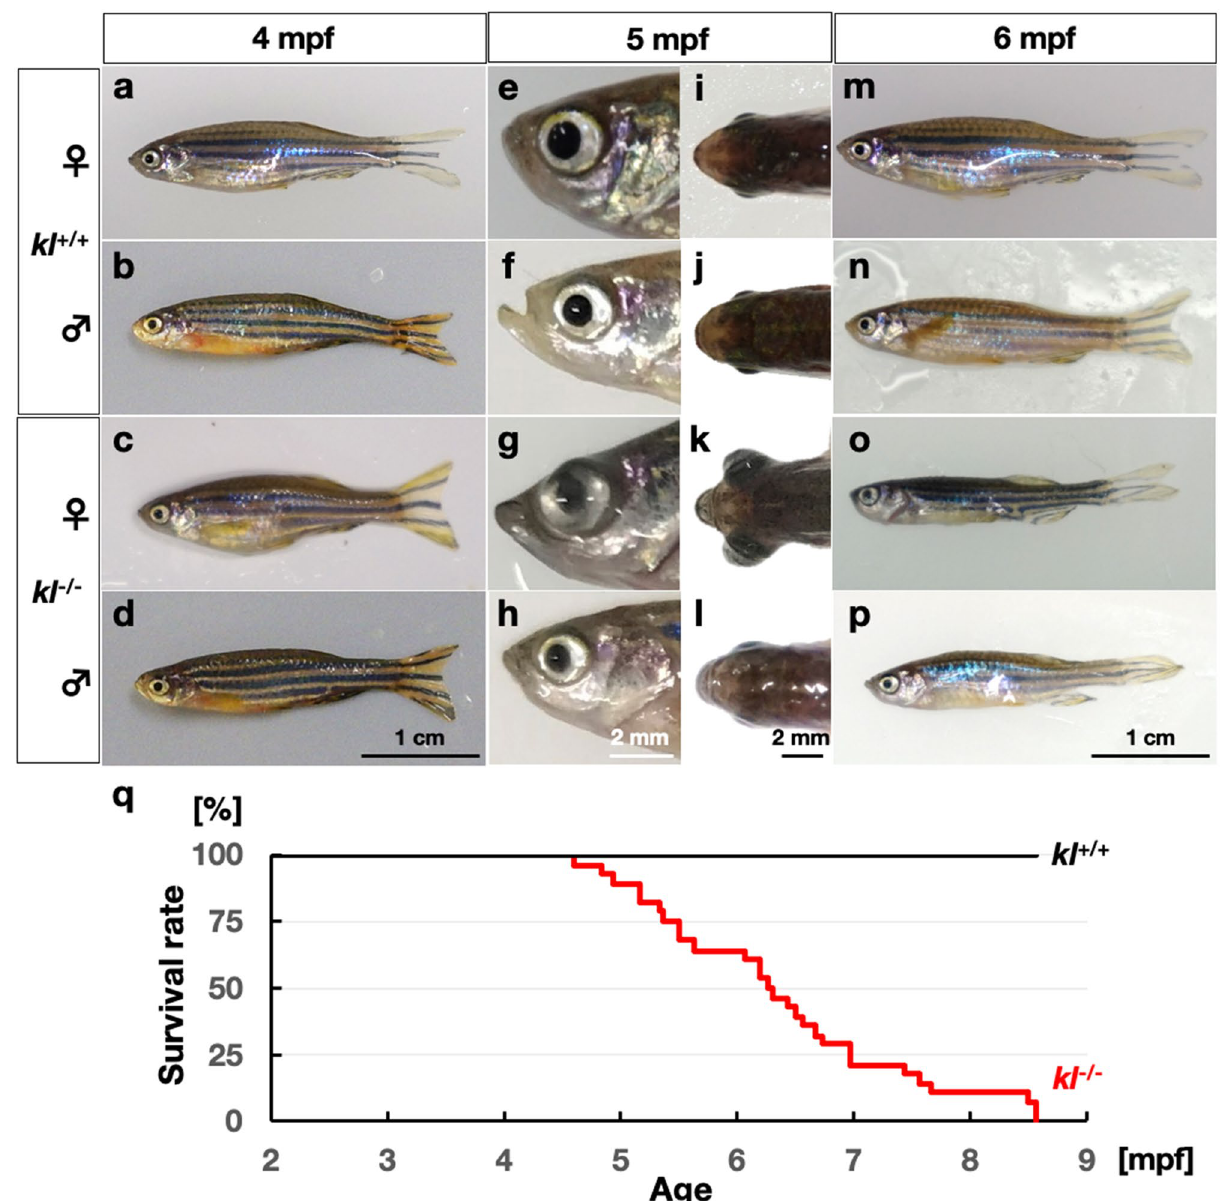
male ( b ), kl −/− female ( c ) and kl −/− male ( d ) zebrafish at 4 mpf. The kl −/− fish showed no morphological defects at this stage. ( e – l ) Lateral and dorsal views of head in kl +/+ female ( e , i ), kl +/+ male ( f , j ), kl −/− female ( g , k ) and kl −/− ( m ), kl +/+ male ( n ), kl −/− female ( o ) and kl −/− male ( p ) zebrafish at 6 mpf. The kl −/− fish became skinny. ( q )